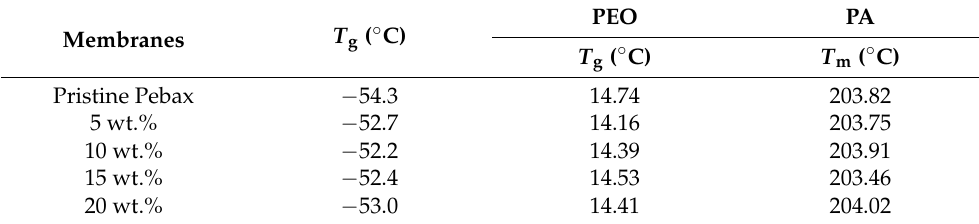
Table 1. Thermal properties of ZIF-8@BNNS/Pebax mixed matrix membranes.